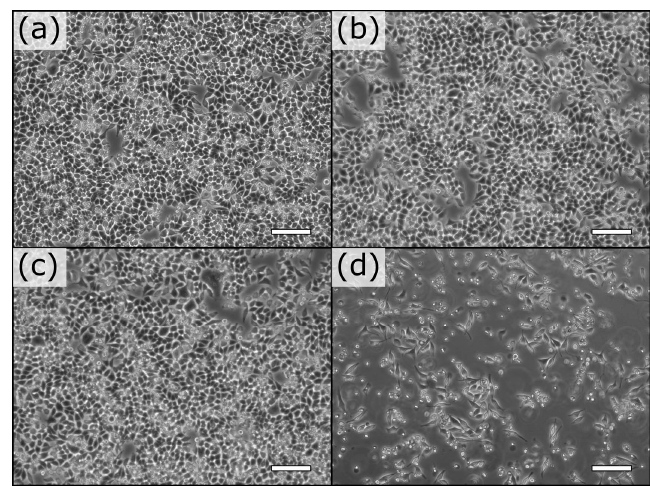
Figure 3. Effect of bacterial delivery of violacein on HeLa S3 cells at MOI of 10. At 4 h post-treatment, there is no observable effect on HeLa S3 cells treated with bacteria expressing empty vector ( a ); vioA-E operon ( b ); invasin ( c ); but internalization of vioA-E ( d ) resulted in the loss of 65% of the cells. Scale bars represent 100 μ m.